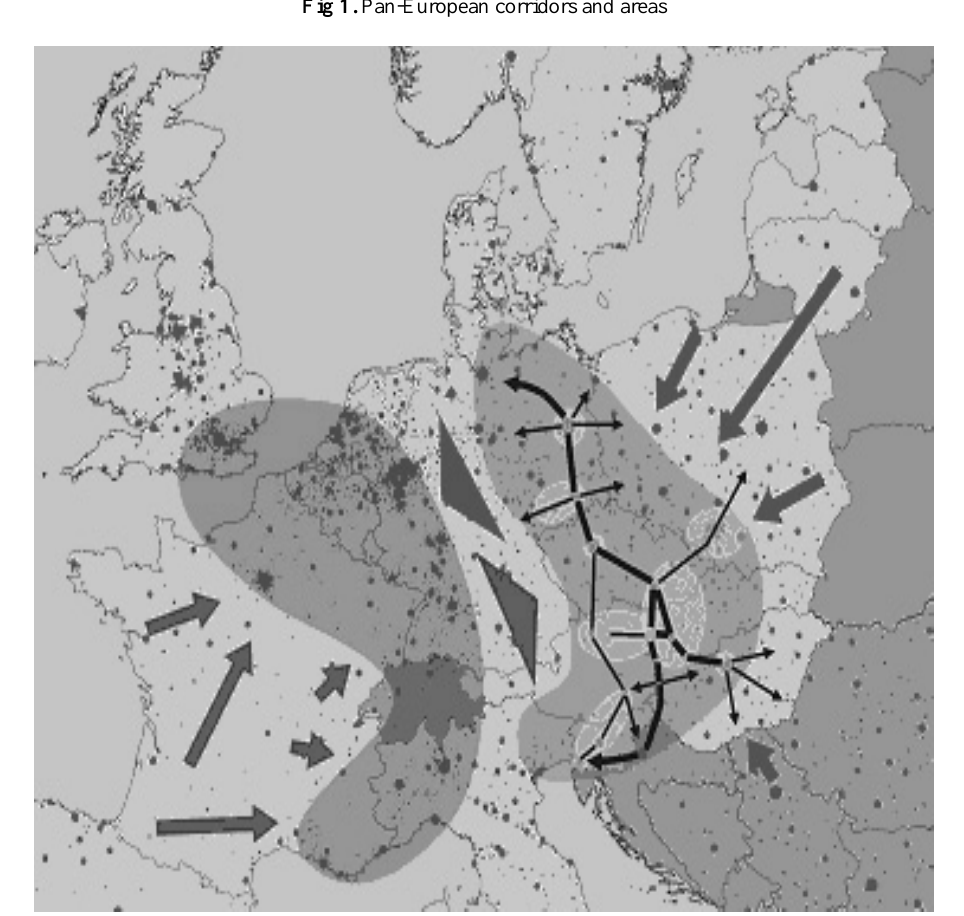
Fig 2. Development of a second economic core area in Central-East-Europe (source IPE GmbH,